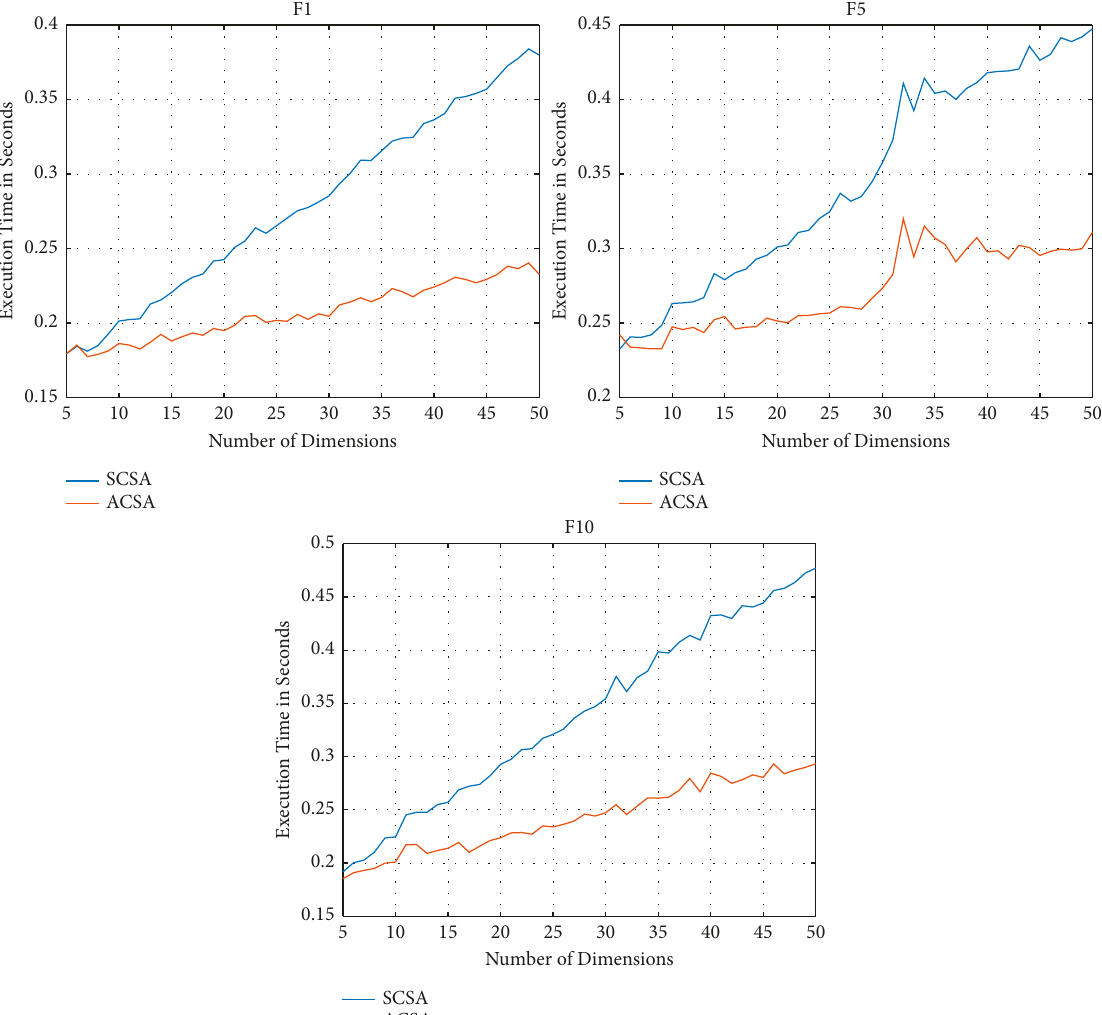
Figure 6: Plots of execution times of SCSA and ACSA against number of dimensions of benchmark